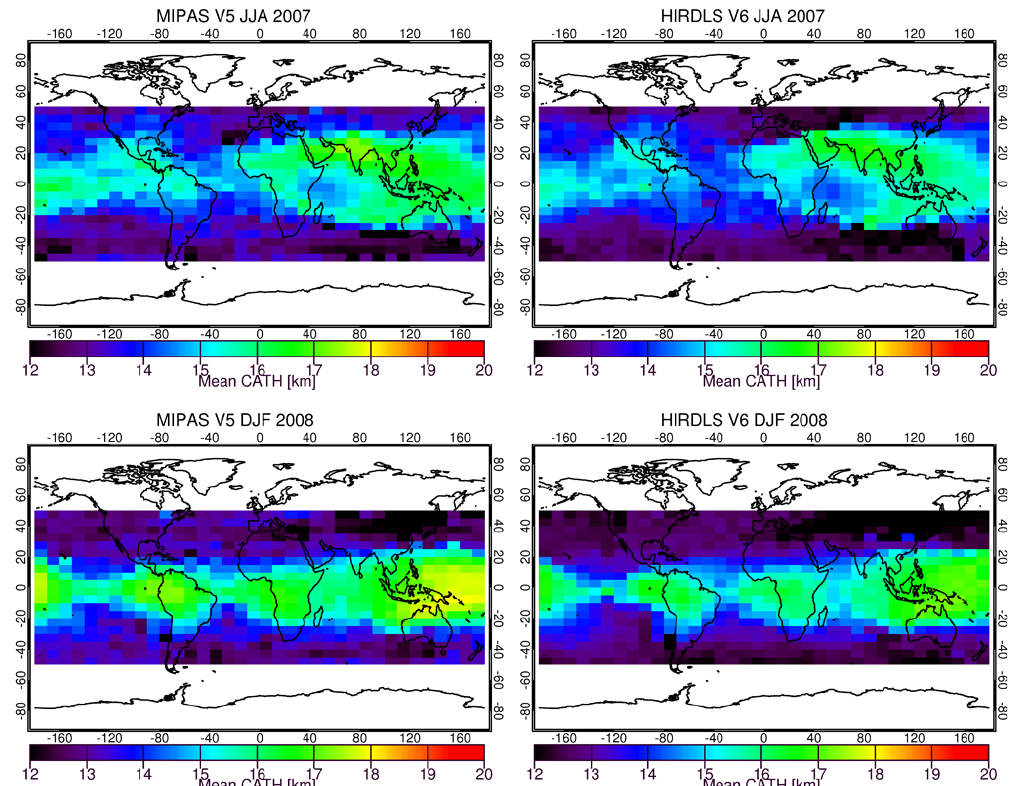
Fig. 5. MIPAS and HIRDLS mean CATH for JJA 2007 and DJF 2007/2008 in the range of 12km to 20km between 50 ◦ N and 50 ◦ S on a 5 ◦ latitude and 10 ◦ longitude grid. Top left: MIPAS JJA 2007, top right: HIRDLS JJA 2007; bottom left: MIPAS DJF 2008 and bottom right HIRDLS DJF